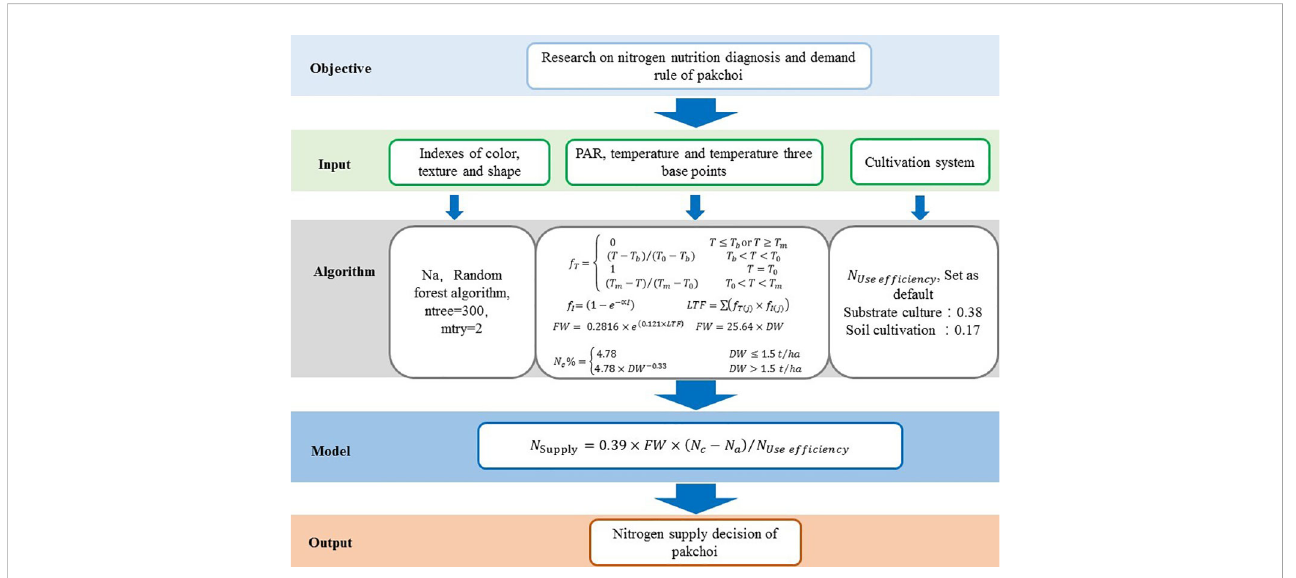
FIGURE 8 An overview of the N demand status model based on three experiments under different N applications in